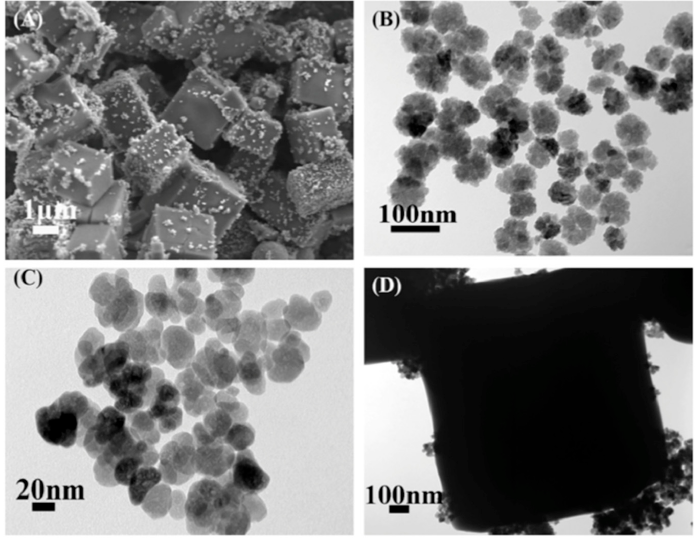
Figure 5. SEM image of Fe 3 O 4 @PEI-MOF-5 ( A ); TEM images of Fe 3 O 4 ( B ), Fe 3 O 4 @PEI ( C ), Fe 3 O 4 @PEI-MOF-5 ( D ). Adapted with permission from [75]. Copyright (2018)